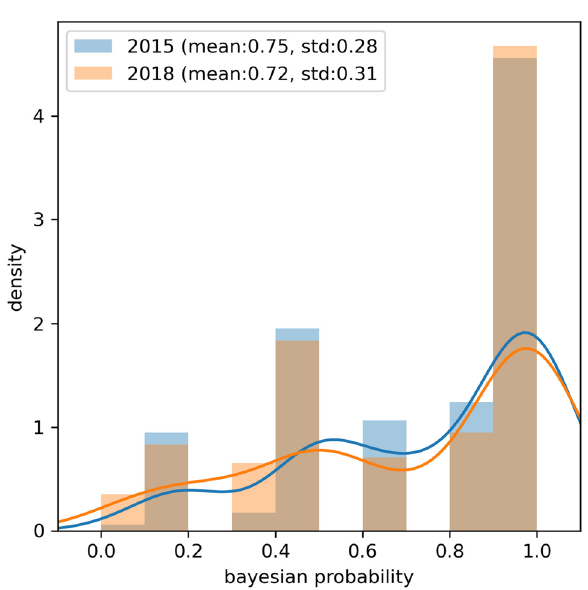
Figure 2. Comparison of Bayesian values between the 2015 ACMG/AMP and 2018 HL-EP